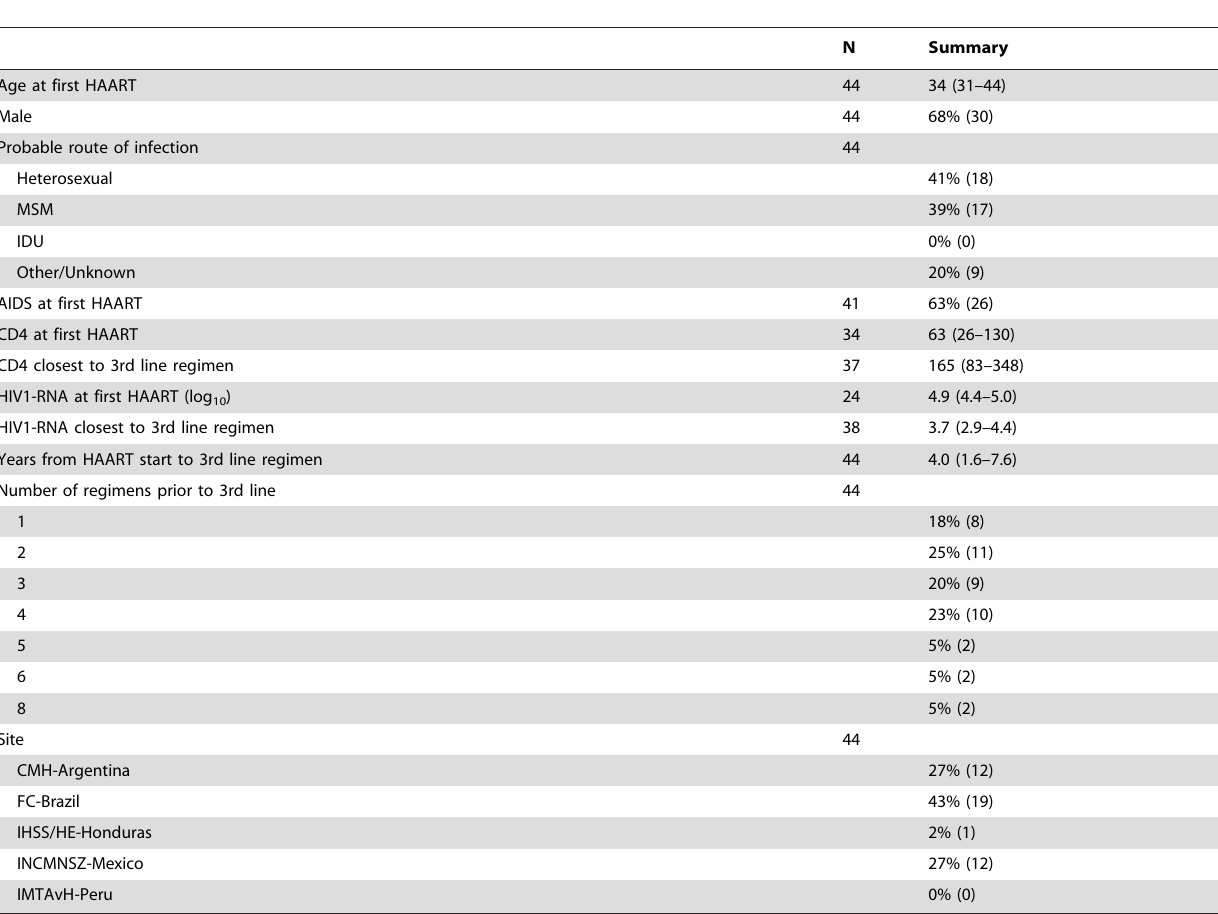
Table 3. Third line regimen patient’s